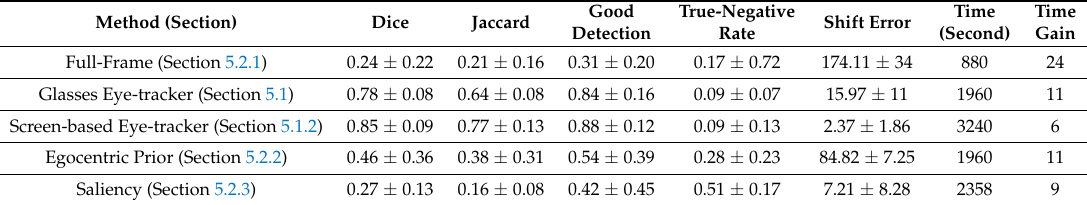
Good True-Negative Time Time Shift Error Detection Rate (Second) Gain